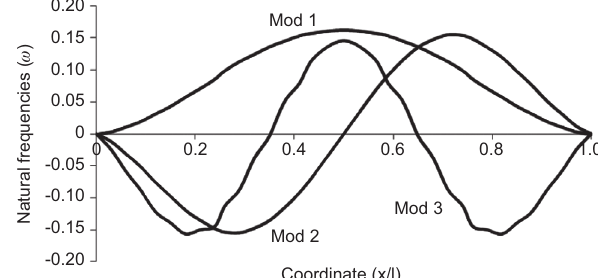
Figure 7 The first three mode shapes of symmetric (45 ° /-45 ° ) s composite beam for the SC boundary